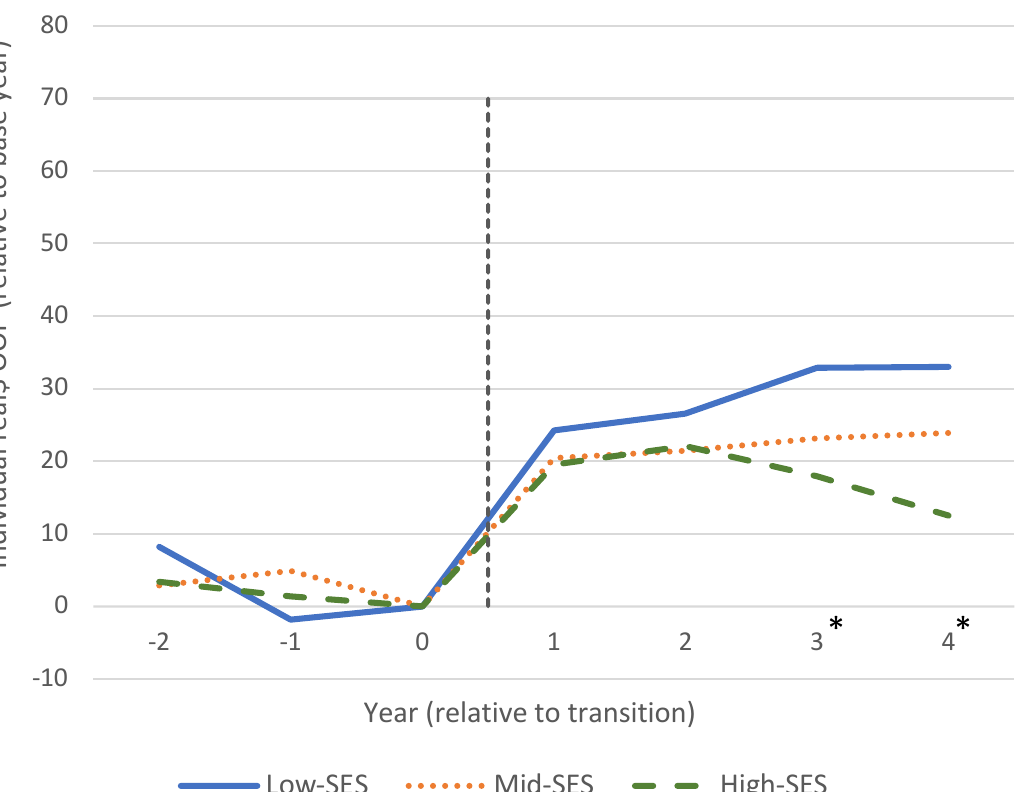
Figure 4: Estimated effects of choice devolution on annual OOP medical expenditure burdens, with premium contribution adjustment. Notes: This figure shows pooled difference-in-difference estimates of changes in OOP medical expenditures among enrollees at firms that transition to devolved choice, with an adjustment to account for differential employee contributions to premiums in high- versus low-deductible plans. SES categories correspond to the bottom 25 percent, middle 50 percent, and top 25 percent of the sample distribution. The model is estimated with year-fixed effects and with person-fixed effects centered at the pre-devolution level. ∗ indicates a statistically significant difference between the high- and low-SES groups at p <